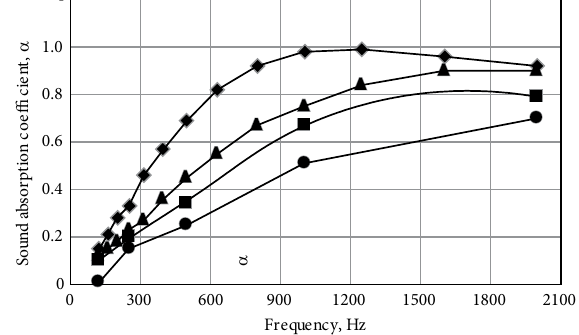
Fig. 4. Kinetic of sound absorption coefficient on sound frequency of hemp fibre composite: Our developed composite (densities, kg/m 3 :  – 40;  – 80) and by other authors (Berardi, Iannace (2015) ( • – 50 kg/m 3 hemp fibre, ■ – 60 kg/m 3 coconut fibre)